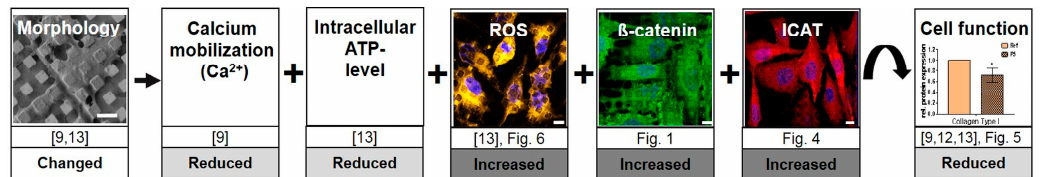
Figure 10. Summary of the complex intracellular responses of MG-63s on micro-pillars which all contribute to reduced cell functions. The sharp-edged micro-pillars (P5) changed the cell morphology (FE-SEM Supra25, Carl Zeiss; Figure S1) [9,13] and hampered the calcium mobilization [9]. Furthermore, a reduced adenosine triphosphate (ATP)-content [13] as well as an increased reactive oxygen species (ROS) production due to cellular stress could be observed (Figure 6) [13]. The protein-level of β -catenin as well as the translocation into the nucleus was increased (Figure 1), but antagonists such as ICAT (inhibitor of β -catenin and TCF-4) (Figure 4) finally lead to an inhibited transcriptional activation. As a consequence, osteoblasts were reduced in their extracellular matrix-synthesis like collagen type I (Figure 5) [9,12,13]. (Scale bars 10 µ m).